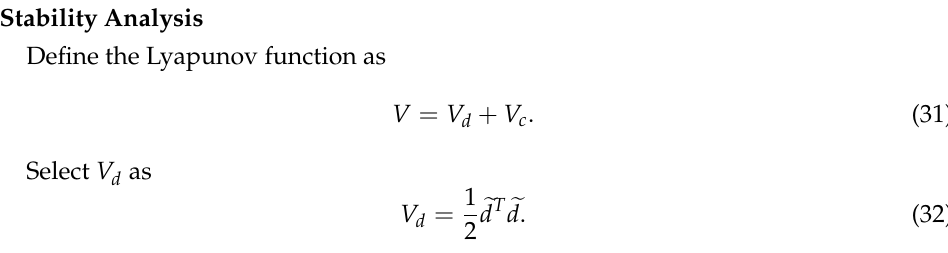
Figure 3. The block diagram of the DP closed-loop control